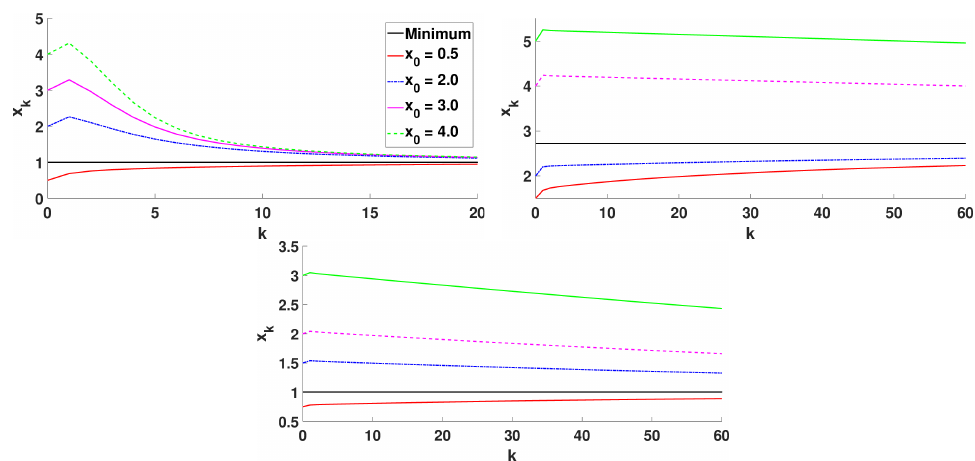
Figure 3. Algorithm 1 for different initial approximations, x 0 .